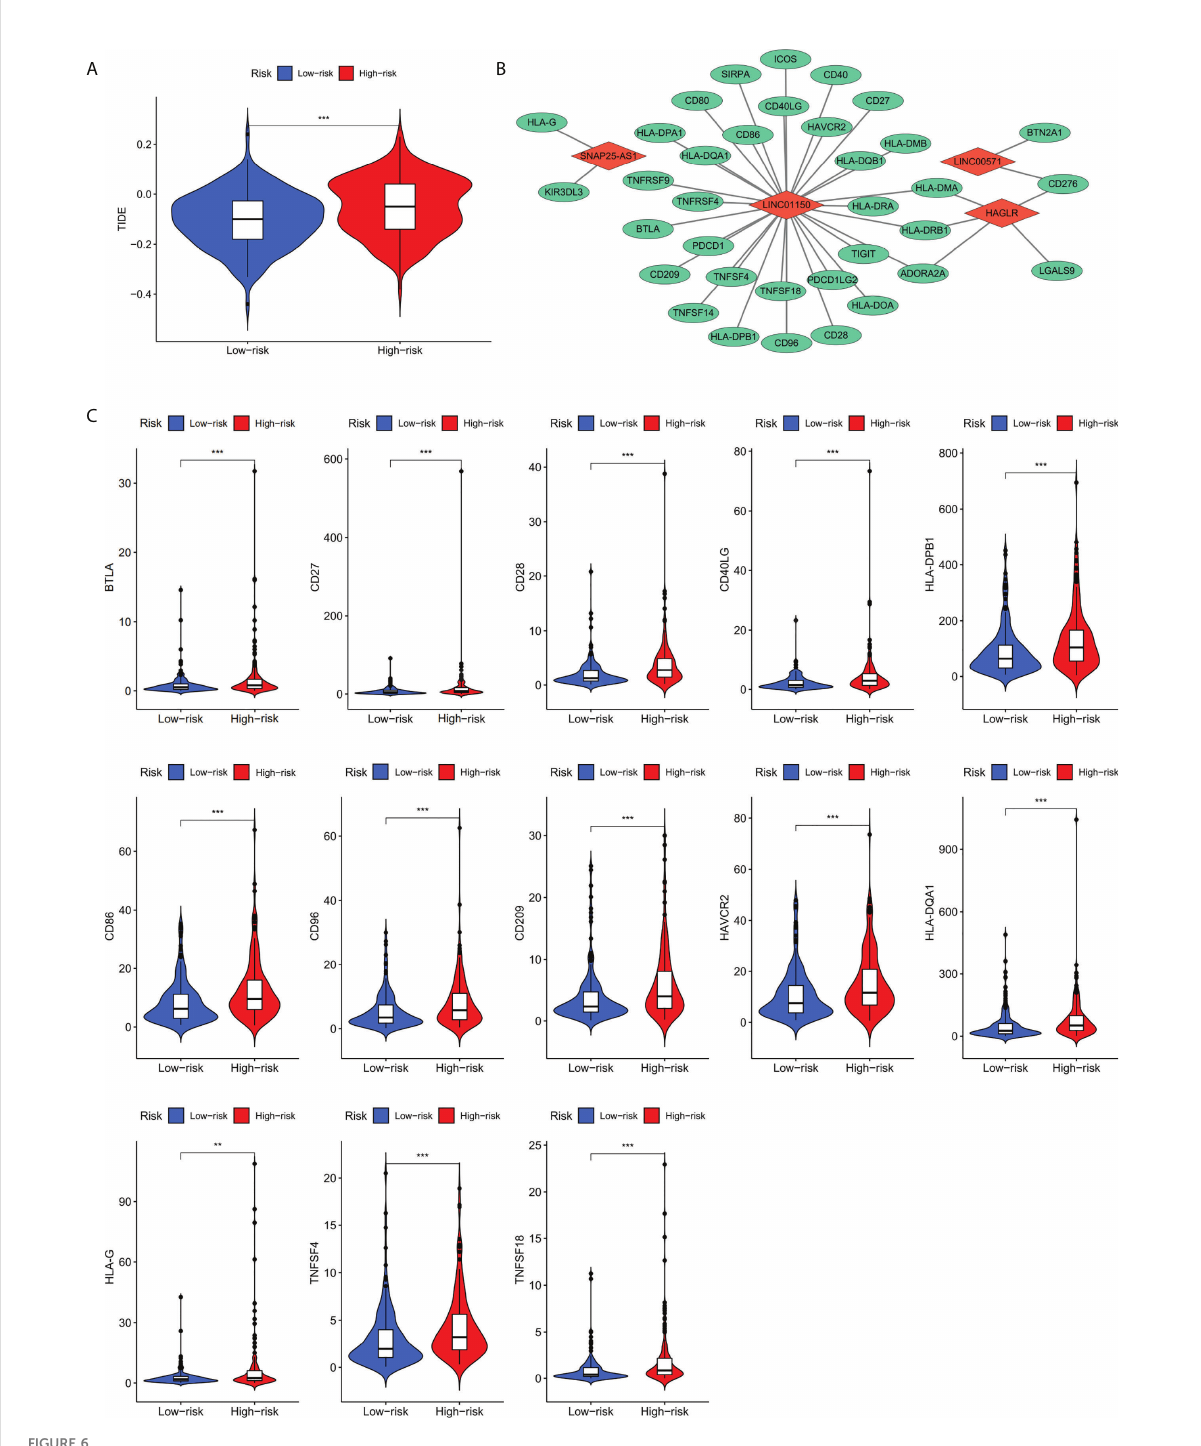
FIGURE 6 (A) TIDE scoring for immune evasion and ICB resistance in high-risk and low-risk groups. (B) The co-expression network between four screened lncRNAs with immune checkpoint genes. (C) Thirteen differentially expressed immune checkpoint genes co-expressed with four cuproptosis- related lncRNAs. **p value<0.01,***p